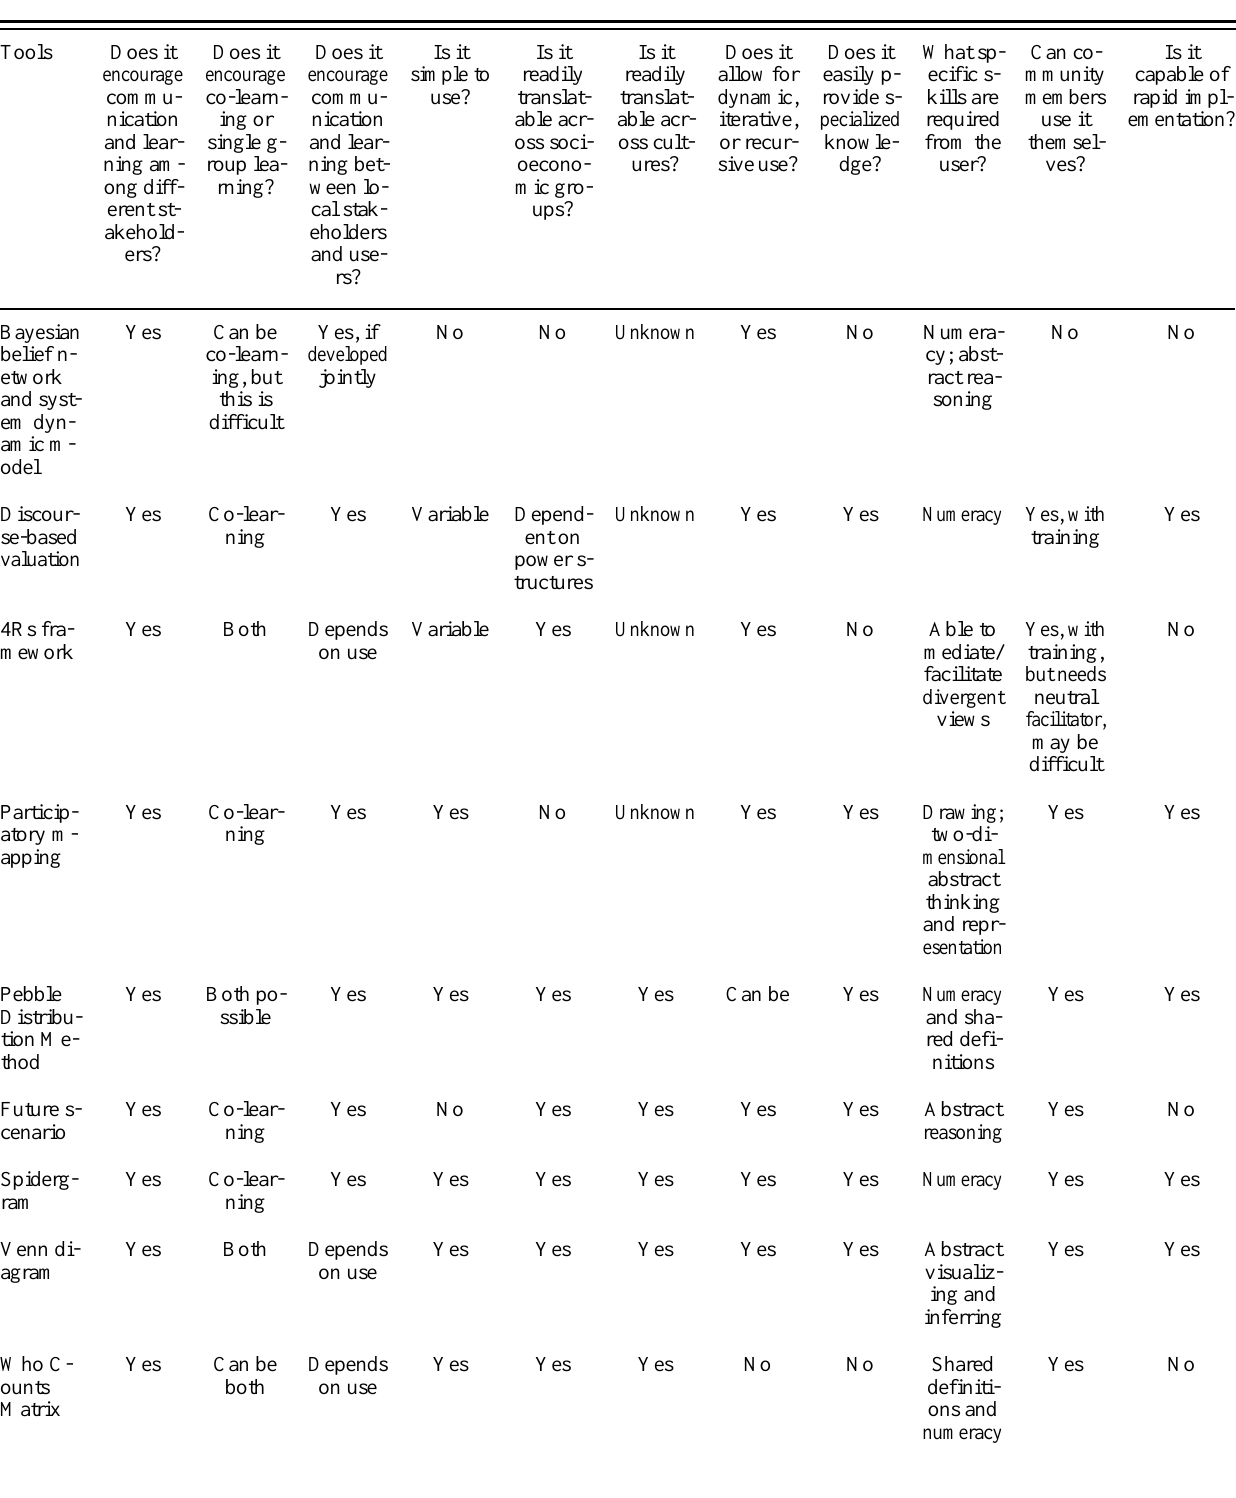
Table 3 . Evaluation criteria applied to each of the tools reviewed: products.